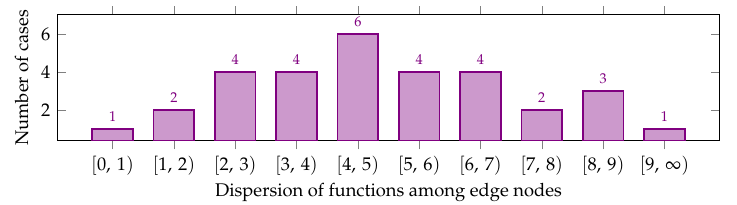
Figure 11. Number of cases in each dispersion interval.